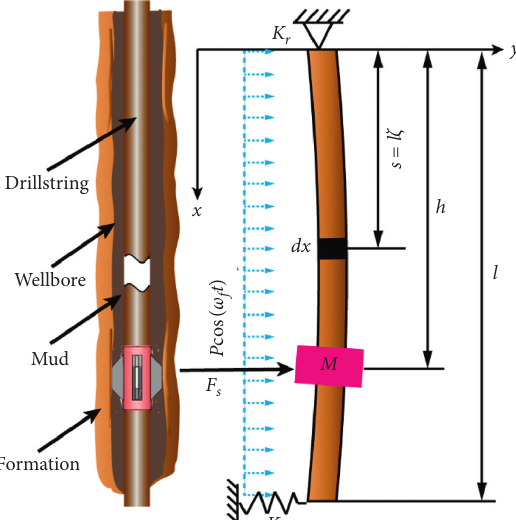
Figure 2: Simplified model to account for fluid forces and stabilizer